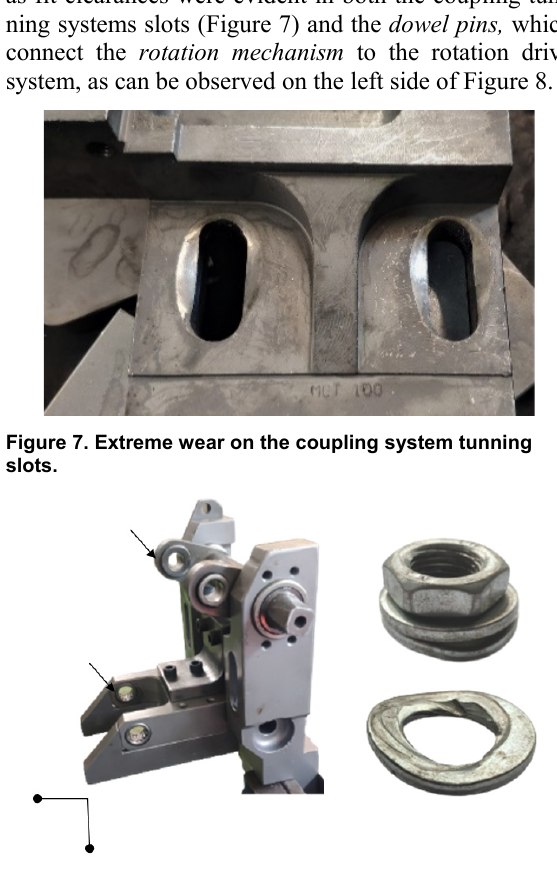
Figure 8. Clearances on the dowel pins that connect to the coupling system and group of washers found on the ZHPIM.